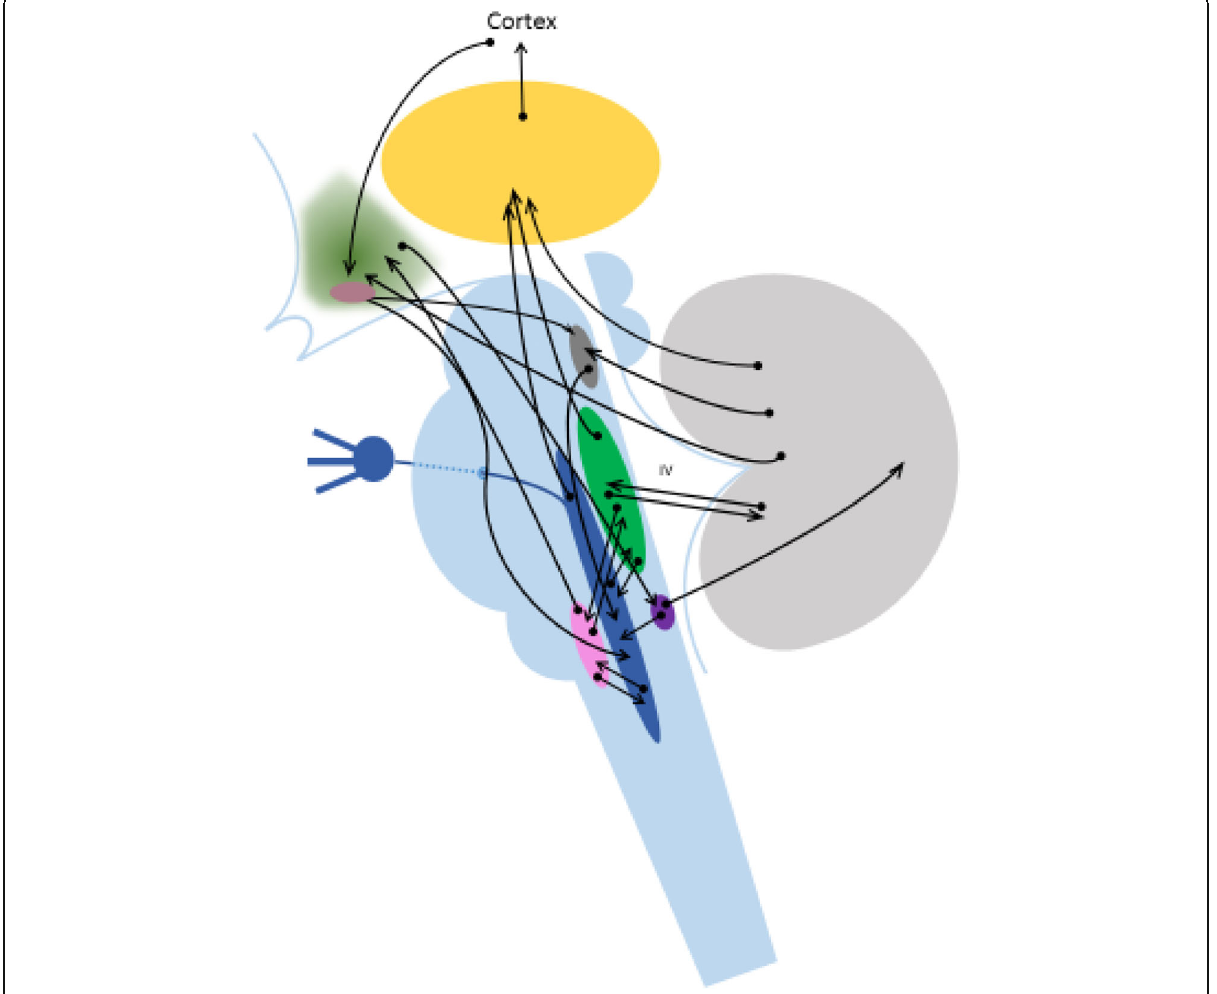
Fig. 1 Schematic and incomplete drawing of hypothalmic and cerebellar pathways involved in the modulation of migraine and probably also of periodic syndromes [136, 155, 162, 163, 167 – 170]. The pathways are not differentiated in excitatory or functionally inhibitory pathways (e.g. the vagal connections to the spinal trigeminal nucleus are functionally inhibitory as it is also shown for the cerebellar pathways to the vestibular nucleus). green = hypothalamus, yellow = thalamus, grey = cerebellum; green = vestibular complex, blue = sensory trigeminal nucleus, pink = area postrema, rose = nucleus ambiguous (as part of the vagal